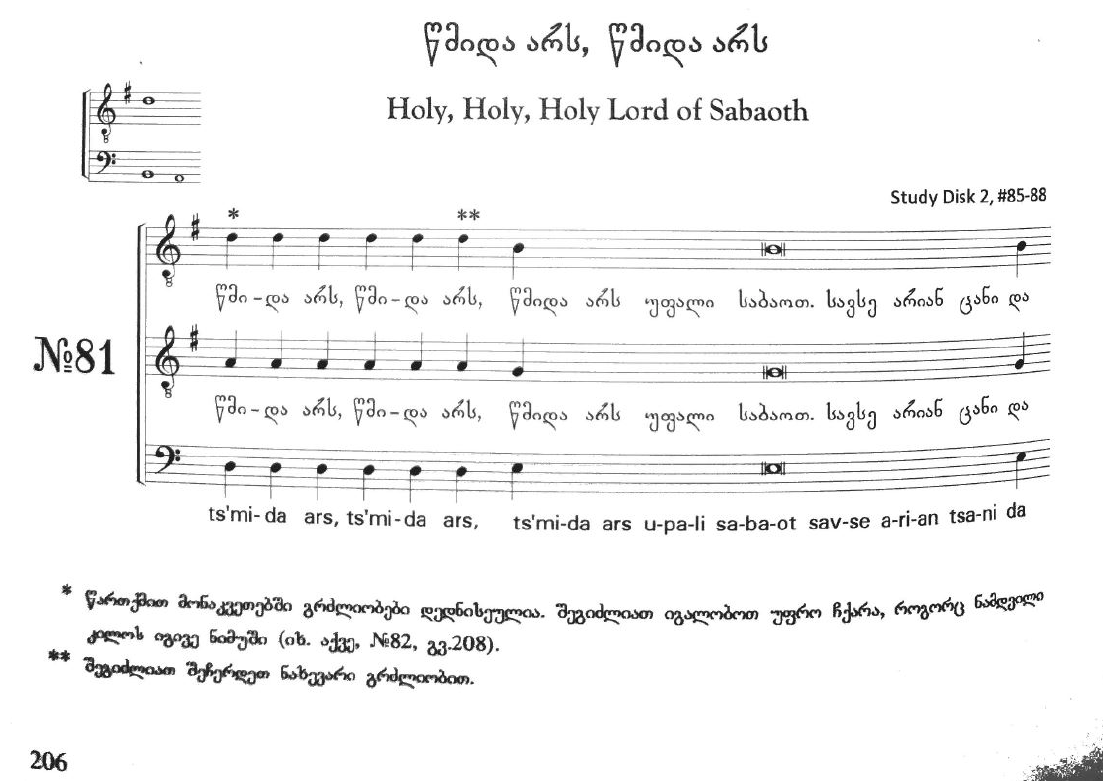
Figure 17. Holy, Holy, Holy; Gelati School (Chkhikvishvili and Razmadze 2010).